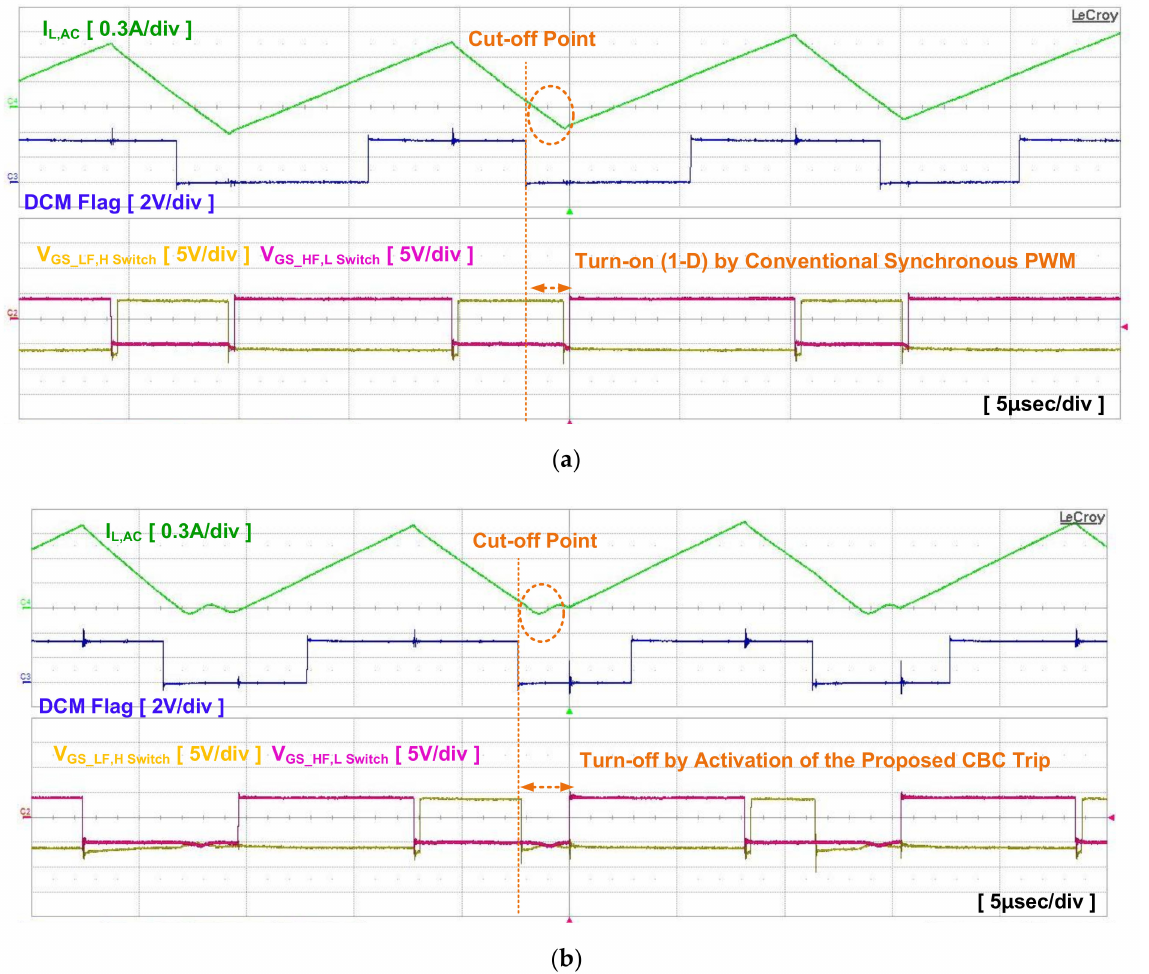
Figure 9. Key waveforms by synchronous PWM operation method. ( a ) conventional synchronous PWM method and ( b ) proposed synchronous PWM